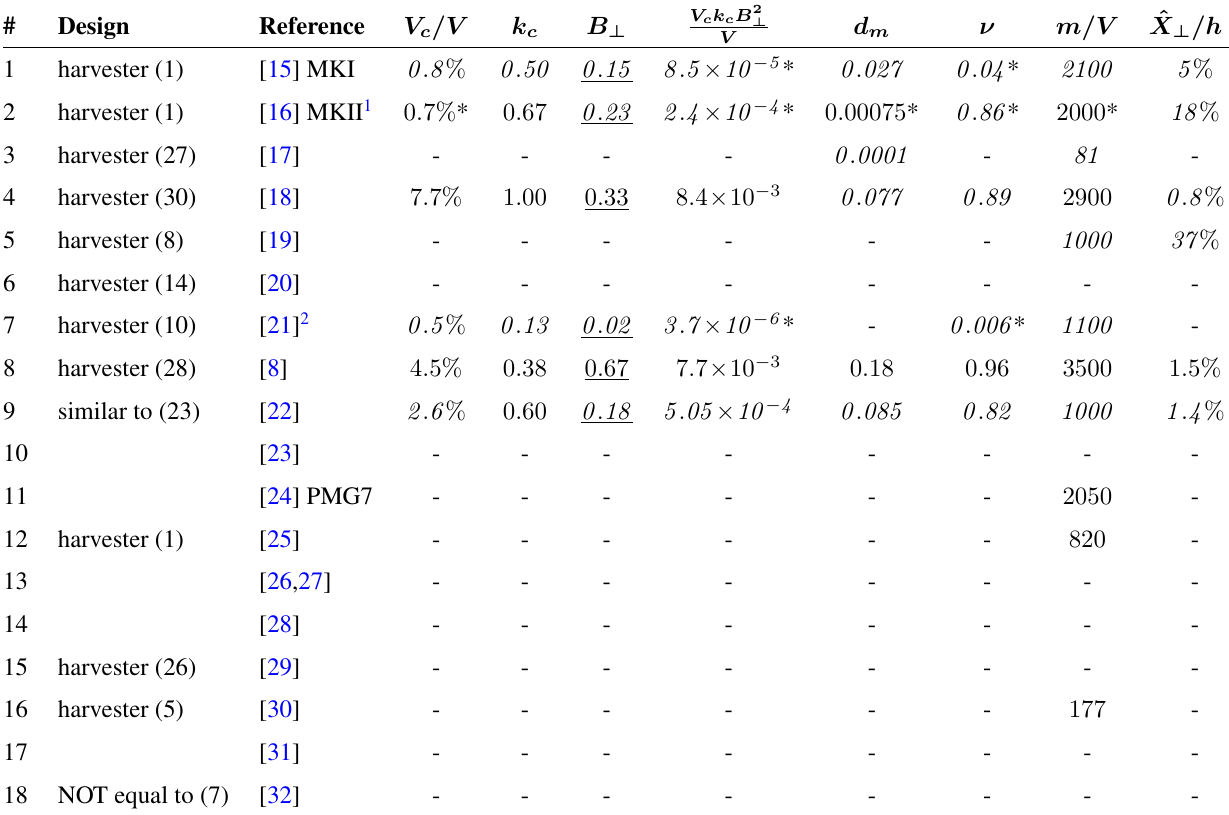
Table 2. Key parameters of selected harvesters in SI units estimated /simulated/ cited/computed* from published values. The column “Reference” denotes the particular publication, column “#” was introduced to refer to the corresponding benchmarking value in Figure 3 and the column “Design” refers to our review paper [1] to provide the design principle of the harvester. Note: the key parameters are according to measurement data that provide maximum performance according to BP (c) in Section 3. B wire was not perpendicular to direction of